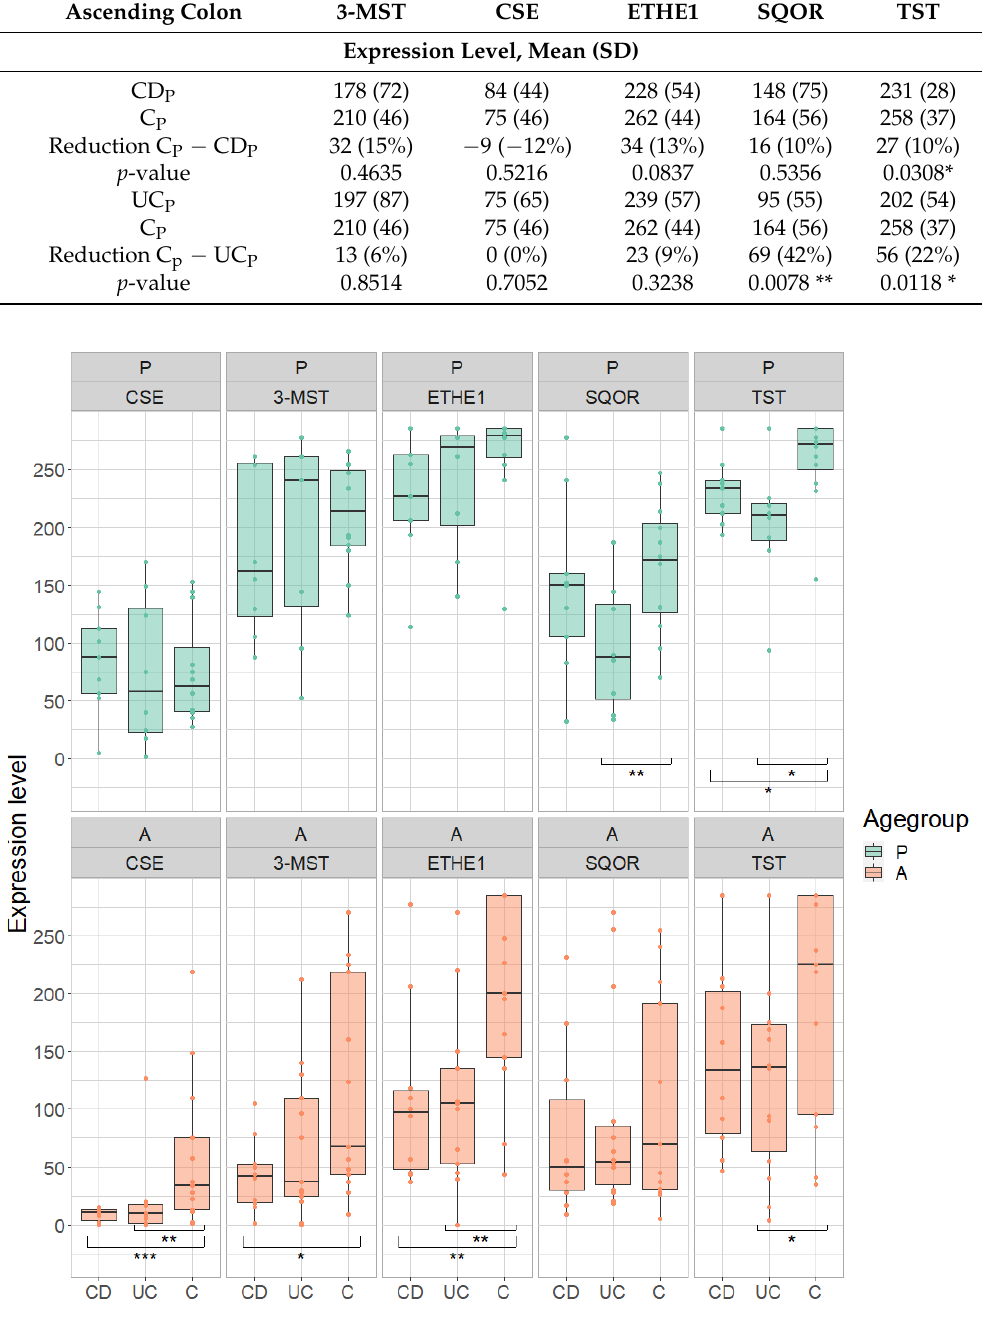
Figure 10. Expression of cystathionine- γ -lyase (CSE), 3-mercapto-sulfurtransferase (3-MST), ethylmalonic encephalopathy 1 protein (ETHE1), sulfide:quinone oxidoreductase (SQOR) and thiosulfate sulfurtransferase (TST) in pediatric (P) and adult (A) samples in the ascending colon in Crohn’s disease (CD), ulcerative colitis (UC) and healthy controls (C). Range of expression levels from a minimum of 0 to a maximum of 300. * = p -value < 0.05, ** = p -value < 0.01, *** = p <